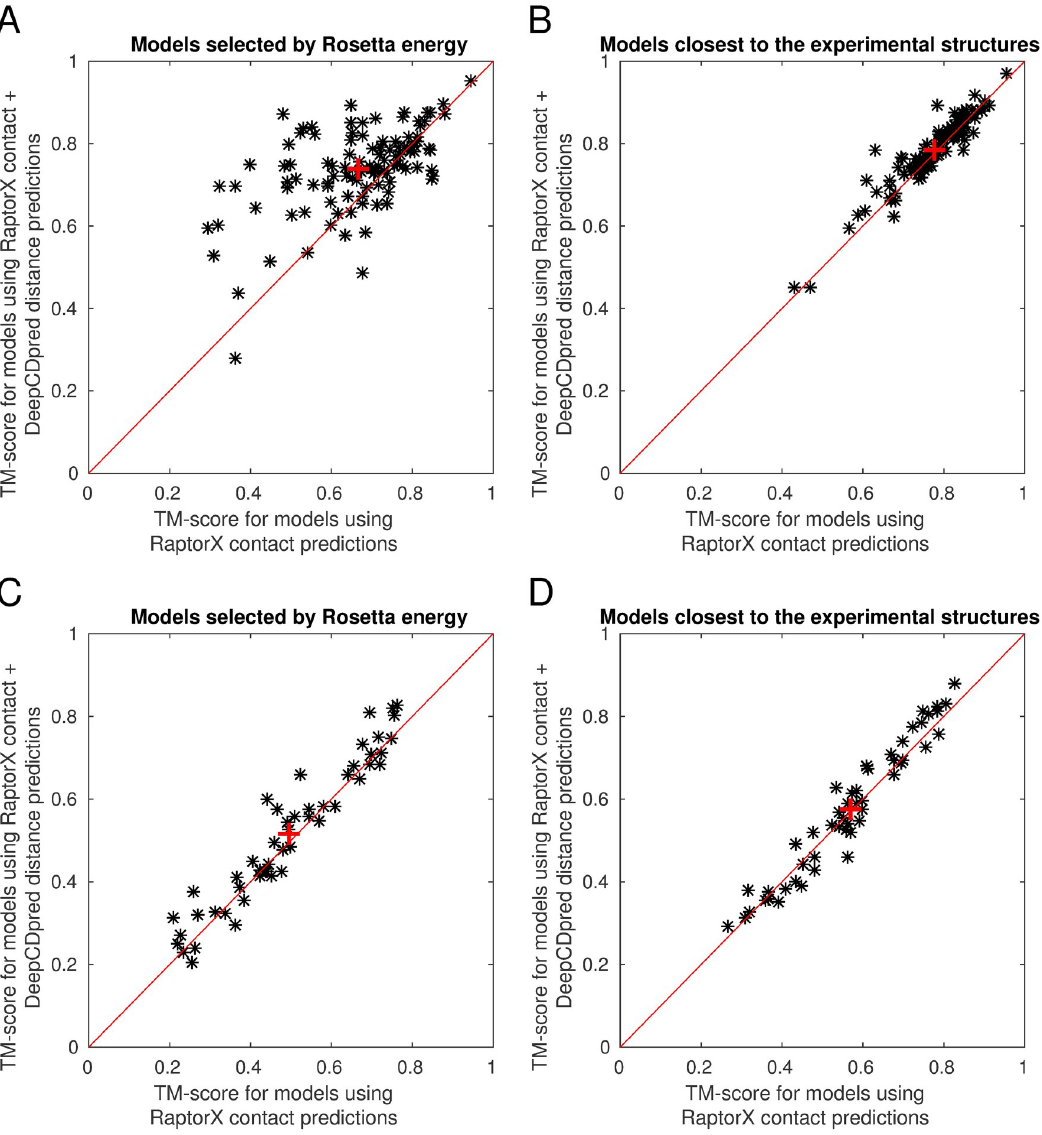
Fig 3. Distance constraints improve structure predictions using Rosetta AbinitioRelax. Addition of distance constraints improves the accuracy of the model with the lowest Rosetta energy (A) and the model closest to the experimental structure (B) for the test set with 108 proteins. For the test set of 50 proteins, distance constraints improve the models with the lowest Rosetta energy (C), but there is small but statistically insignificant improvement in the best model (D). For each test protein 200 structures were generated by Rosetta. The red ‘+’ sign indicates the average